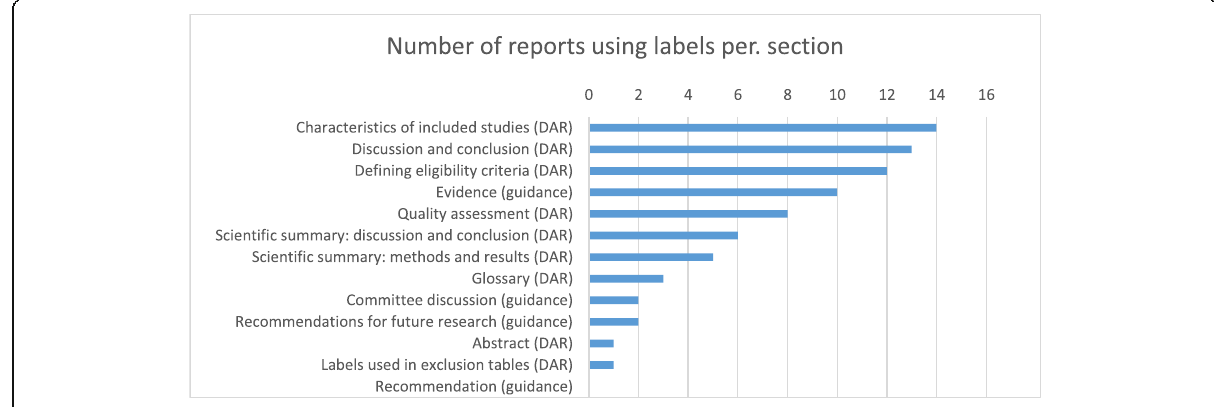
Fig. 2 Frequency of labels used in DARs and